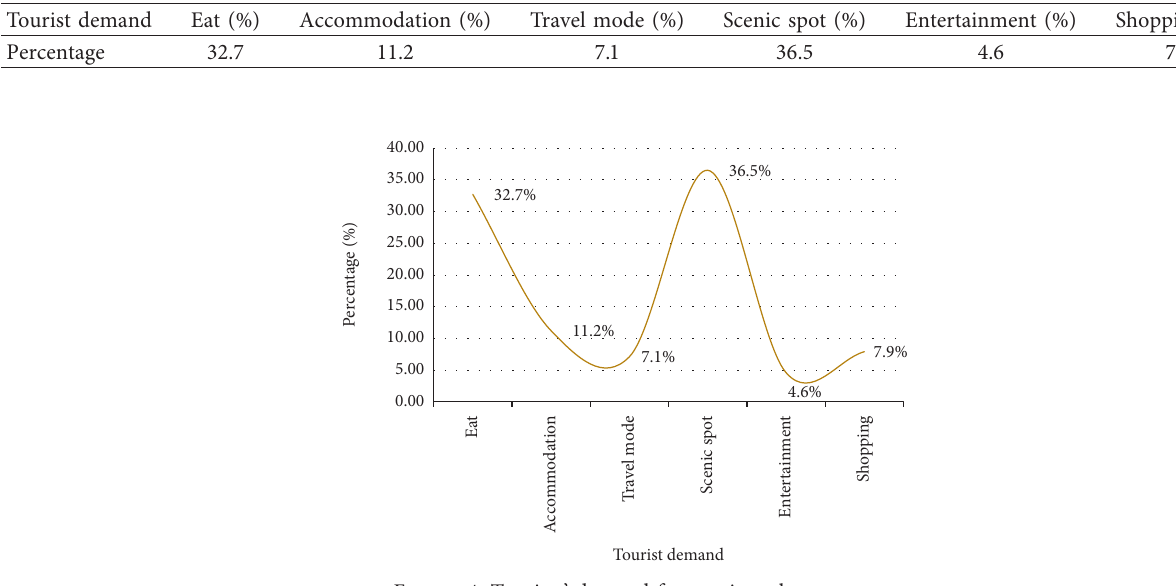
Figure 3: The main target groups of customized tourism. Table 6: Tourists’ demand for tourism elements.